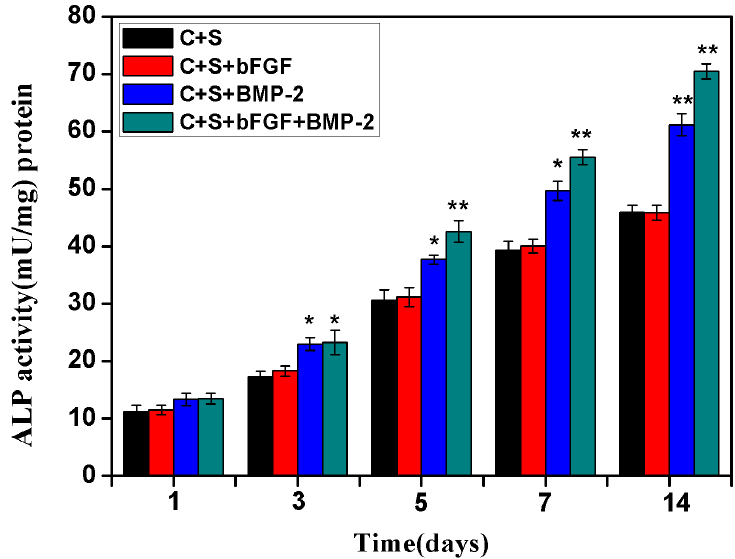
Figure 4. Changes in alkaline phosphatase (ALP) activity of BMSCs in all four groups on culture days 1, 3, 5, 7 and 14. * A value of p < 0.05 and ** A value of p < 0.01 were considered statistically